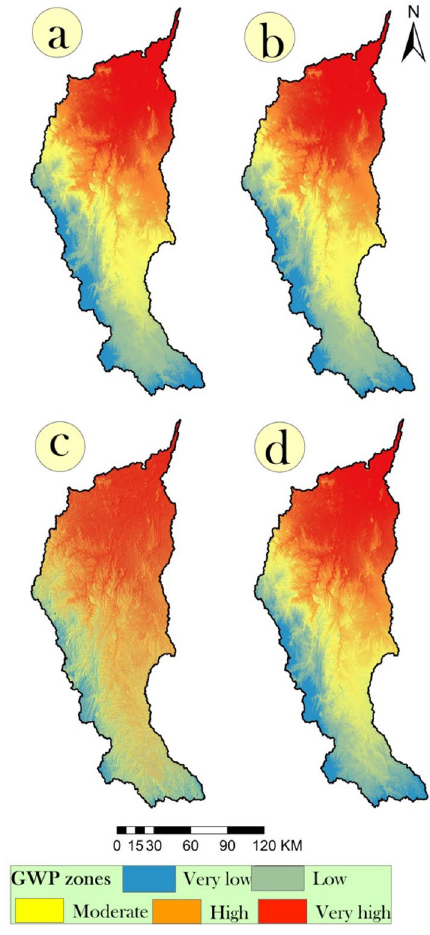
Fig. 6 Groundwater potentiality models using a SVM, b ANN, c LR, and d